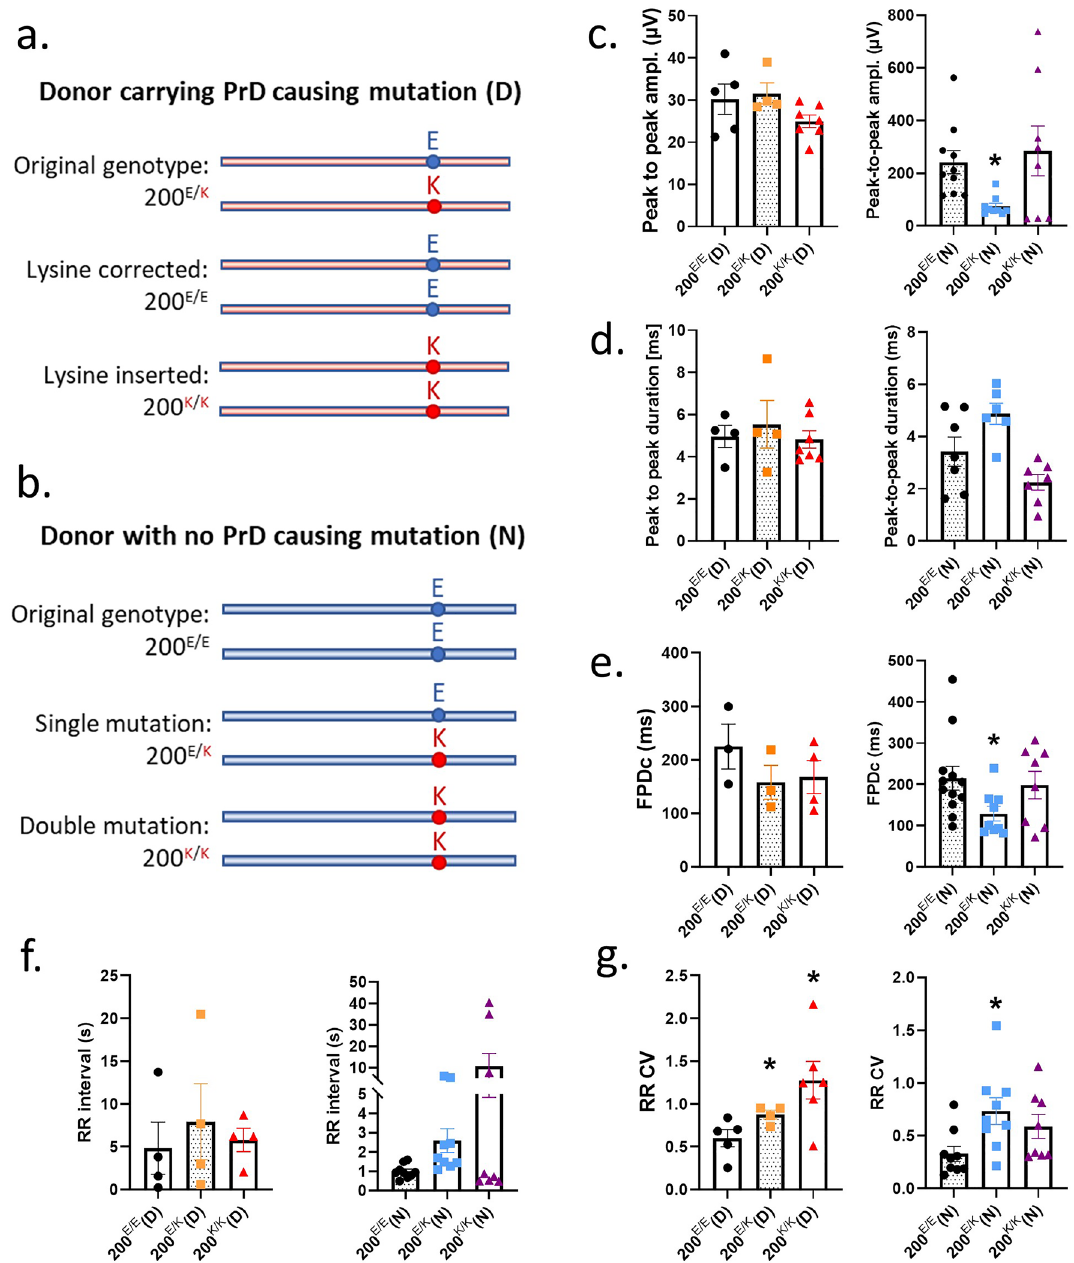
Figure 5. A 200 E/E , 200 E/K and 200 K/K genetically matched cardiomyocytes demonstrate changes in electrophysiology. Schematic representation of the cloning strategies for cells from the donor carrying the PRNP E200K mutation ( a ) and for cells from a donor with no known hereditary disease ( b ) to produce the three genotypes (200 E/E , 200 E/K and 200 K/K ) on the same genetic background (see S13 for detailed information). Graphs showing ( c ) peak to peak amplitude, ( d ) peak to peak duration, ( e ) field potential duration (corrected to RR interval), ( f ) RR interval and ( g ) RR coefficient of variance (variability of the RR interval). Graphs show data points of each independent biological repeat ‘ n ’ with mean and SEM, *p < 0.05, **p < 0.01, and ***p < Fig. 6a and b). Correction of the lysine allele in the carrier donor cells, 200 E/E (D), did not significantly reduce the basal respiration to similar levels observed in control cells (Fig. 6c) or change the maximal respiration (Fig. 6d) but did increase the spare capacity (Fig. 6e). The 200 K/K (D) showed increased basal respiration compared with the isotype controls. Introduction of the lysine allele into the no-known-disease cells significantly increased basal respiration and maximum respiration in both the 200 E/K and 200 K/K cardiomyocytes but did not influ- ence spare capacity (Fig. 6c–e). Following the CRISPR-Cas9 cloning several parameters demonstrated greater consistency, including ATP production (Fig. 6f), proton leak (Fig. 6g) and coupling efficiency (Fig. 6h), the latter of which was no longer significant in the 200 E/K cardiomyocytes compared with the 200 E/E controls. ATP production was significantly increased in the 200 K/K cardiomyocytes from both donor lines and increased in the